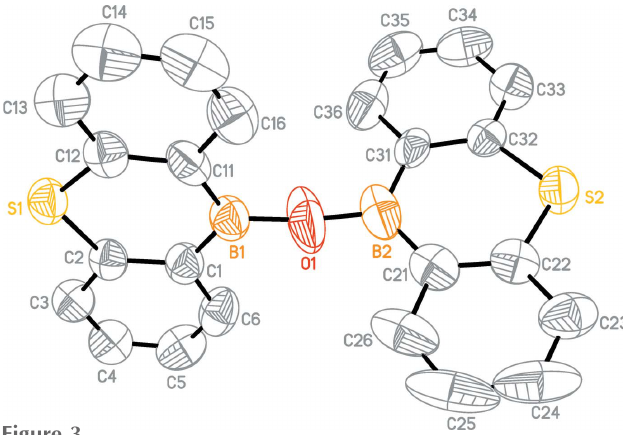
Figure 1 A perspective view of one molecule in the asymmetric unit of (I). H atoms are omitted for clarity.